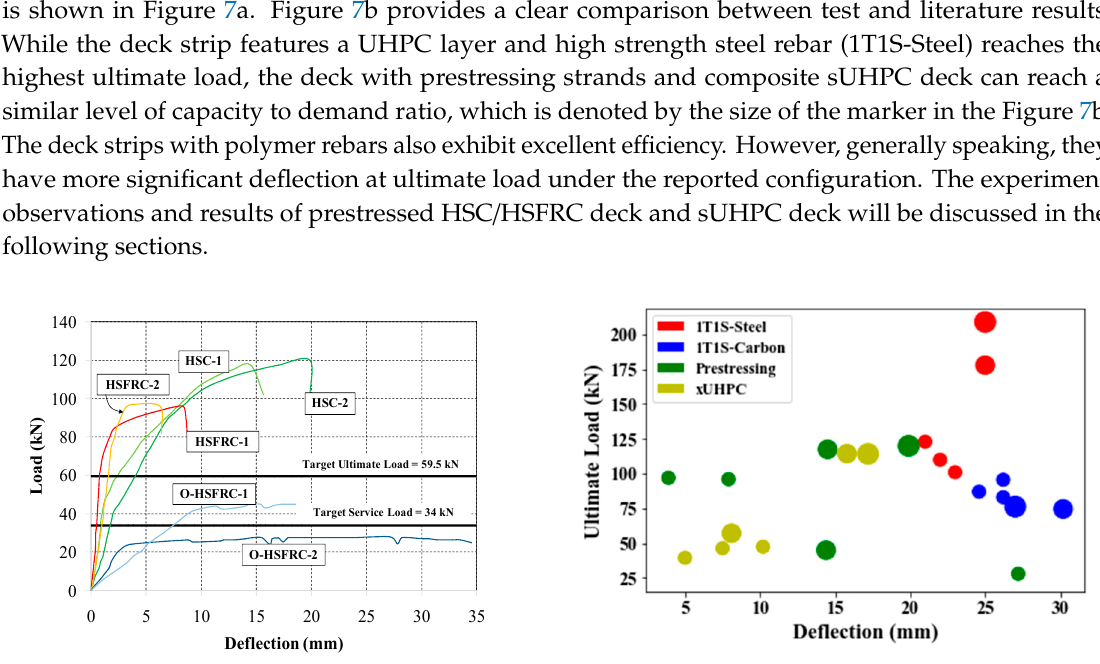
Table 5. Summary of testing results. Ref./Phase